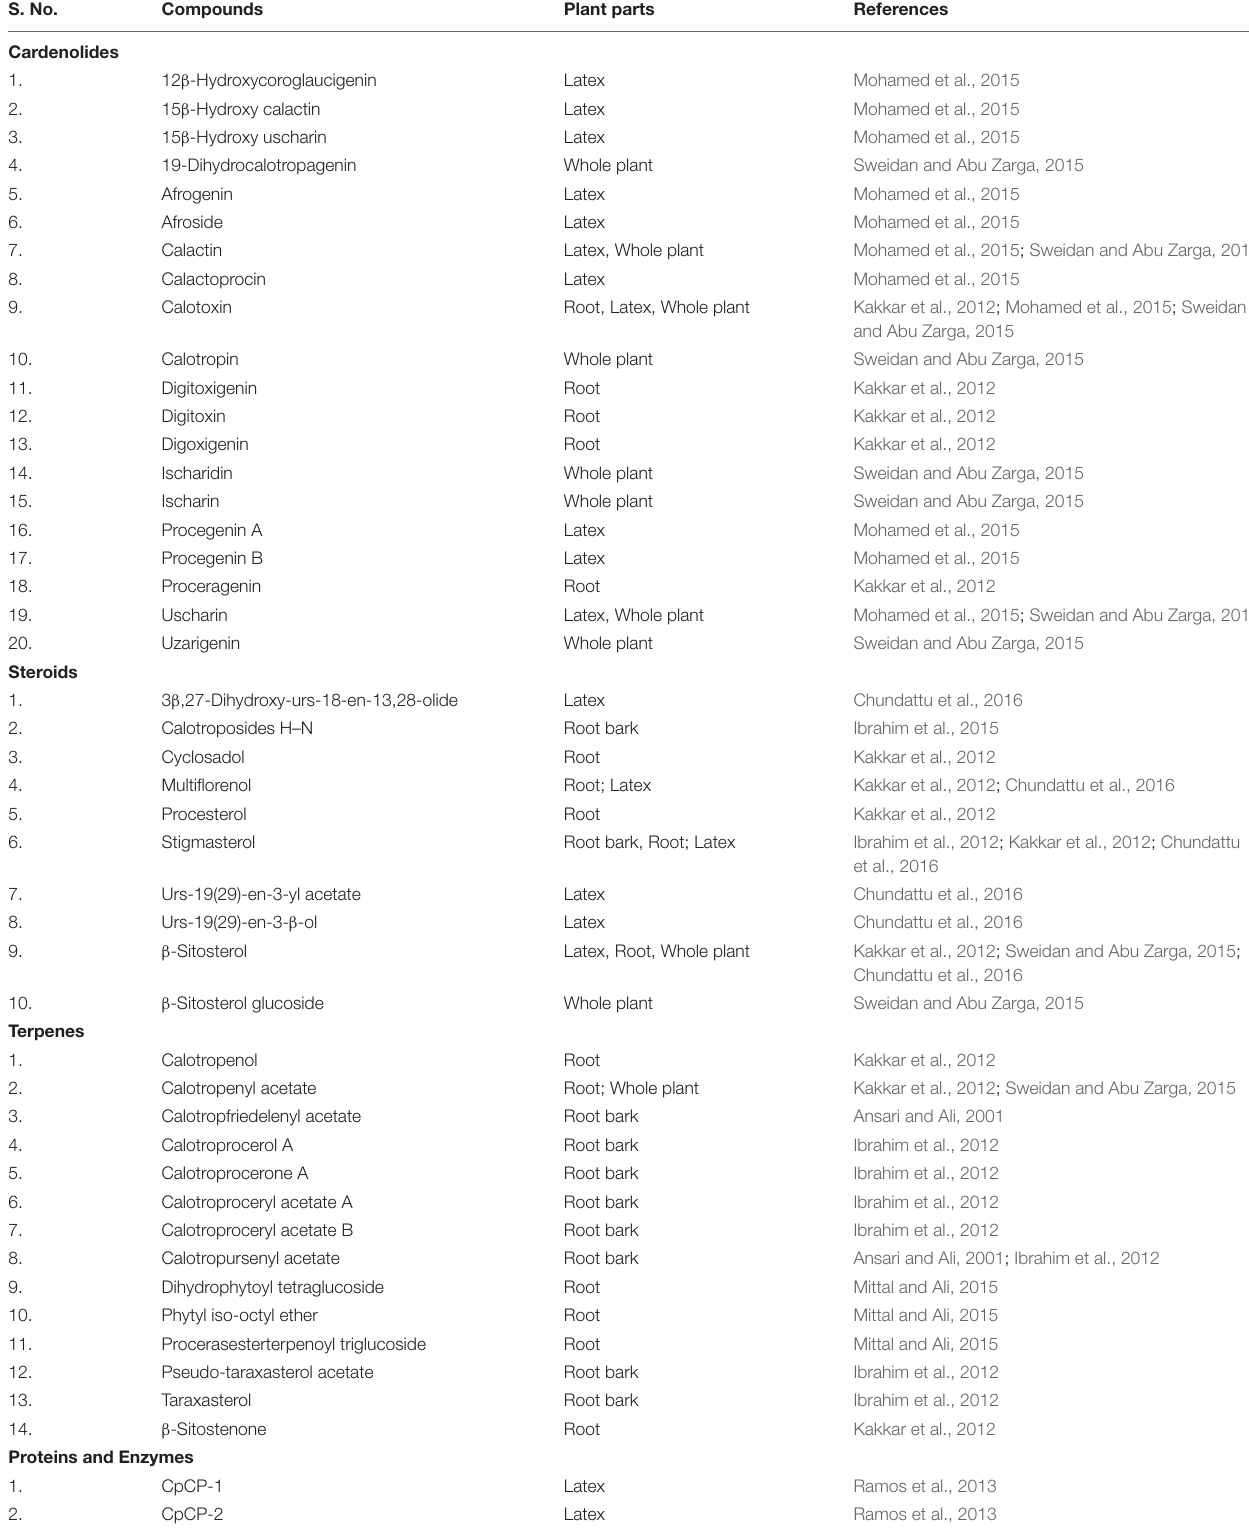
TABLE 1 | Metabolic profile of Calotropis procera. S.